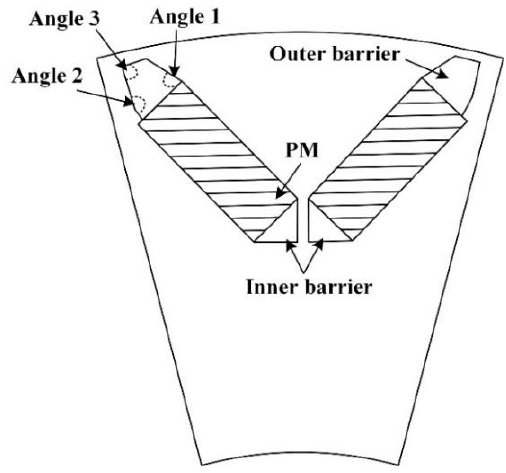
Figure 6. Design variables of rotor.